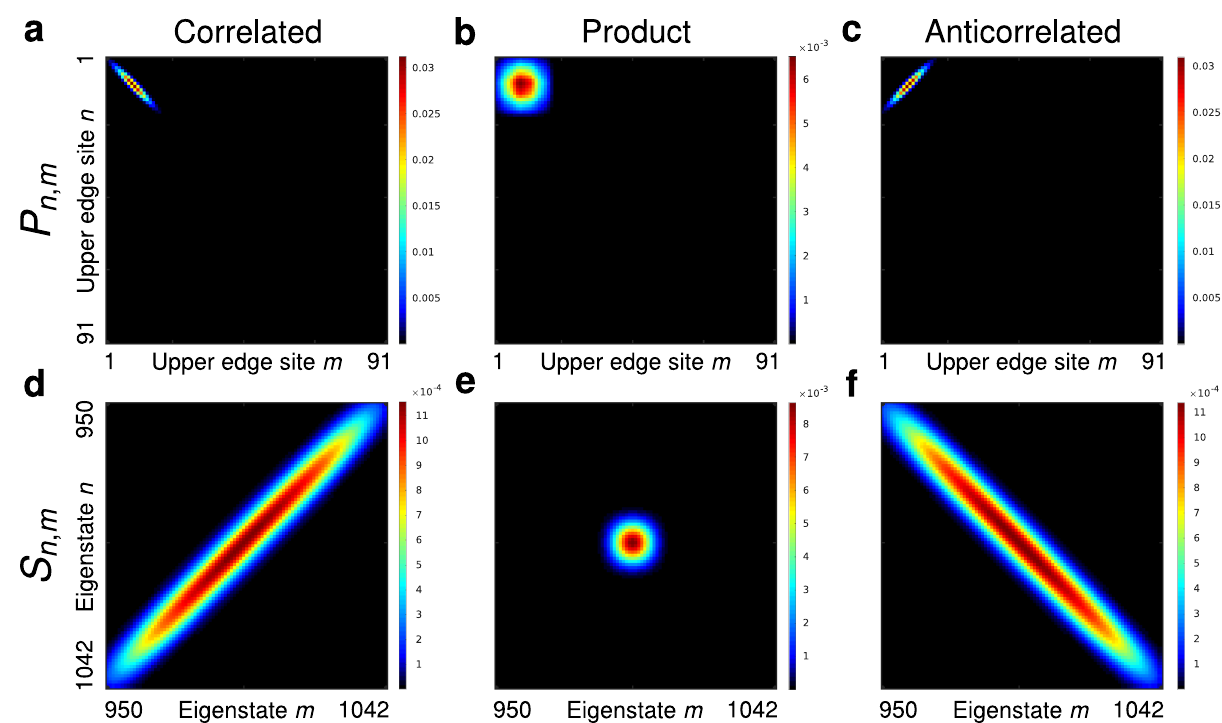
Fig. 2 Initial two-photon states. a , b , c Spatial correlation maps P n , m over the 91 sites of the upper edge of the lattice. d , e , f Spectral correlation maps S n , m in the E (cid:2) E -subspace. a , d correspond to the strongly spatially correlated state ψ ð 2 Þ ffiffiffiffiffiffi p ffiffiffiffiffiffi p ; σ Þ ¼ ð ; Þ , and c , f for the strongly spatially anti-correlated state ψ ð 2 Þ ð σ 40 40 c a